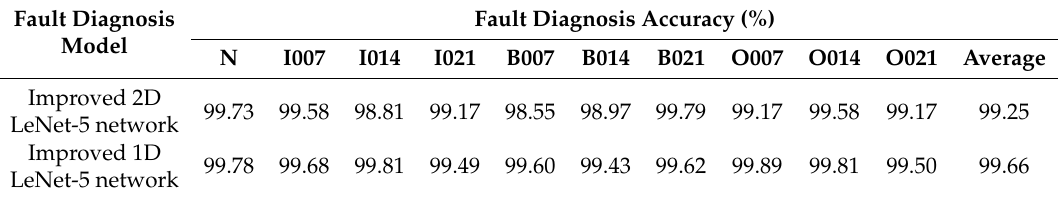
Table 7. Fault diagnosis accuracy of different conditions of rolling-element bearing.